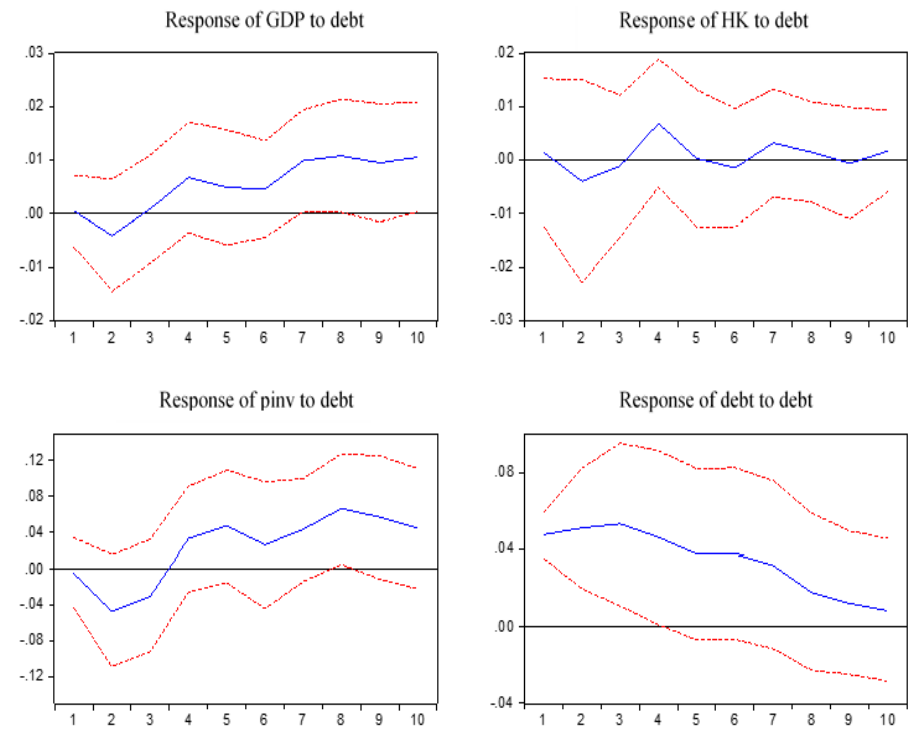
Figure 4: Response of Government Debt, Private Investment, Per Capita Output and Hu - man Capital Stock to a Generalized 1 SD Innovation in Government Debt, Malaysia, 1985-